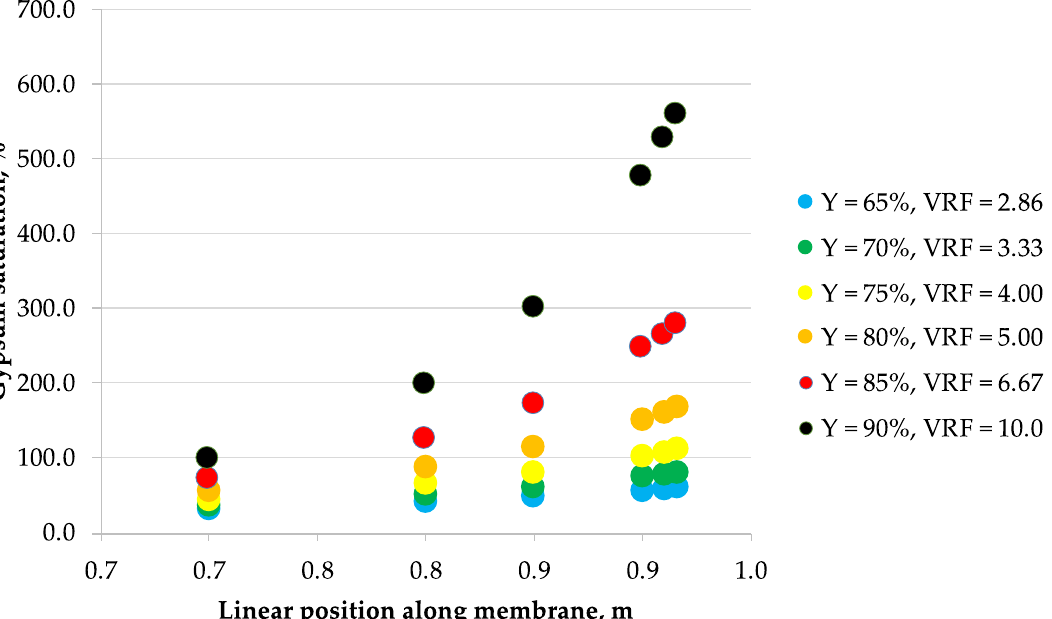
Figure 4. Saturation vs. position along the membrane for mine water A (0.384 g / L as Cl − , 1.02 g / L as SO 42 − , 0.107 g / L as Na + , 0.142 g / L as Mg 2 + , 0.312 g / L as Ca 2 + ) and NFX nanofiltration membrane.